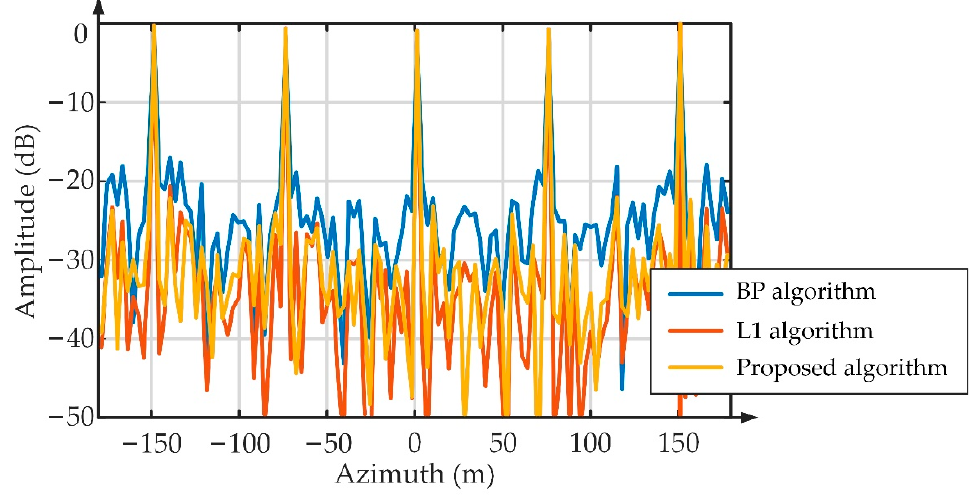
Figure 11. Illustration of the azimuth profile.